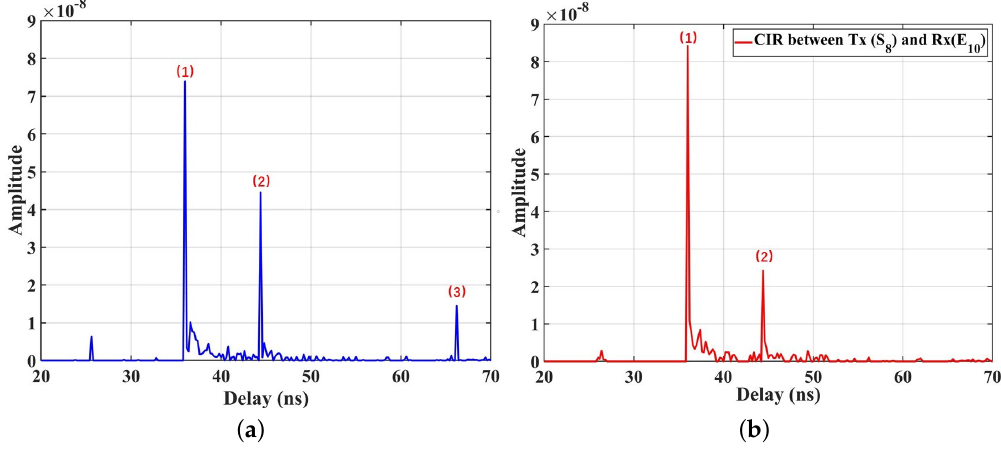
Figure 2. ( a ) NLOS components of CIR for PD D 10 ; ( b ) NLOS components of CIR for PD E 10